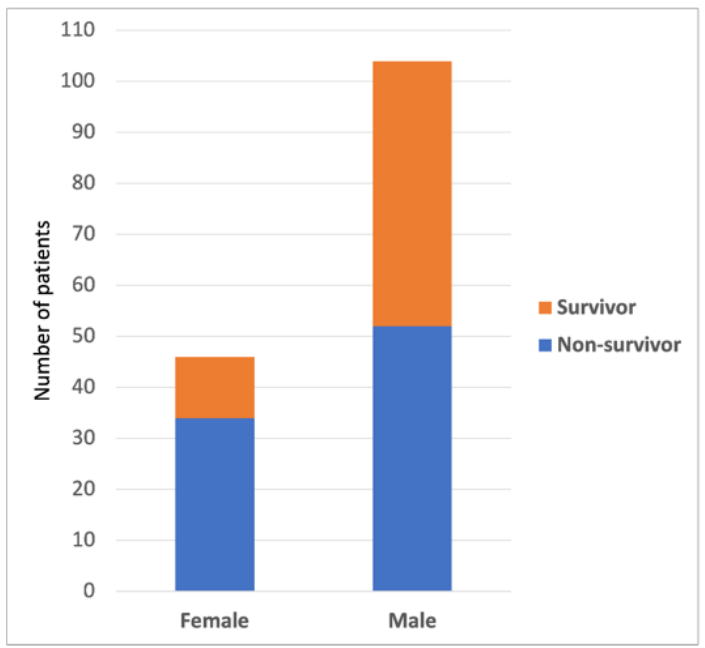
Figure 1. Gender mortality distribution.